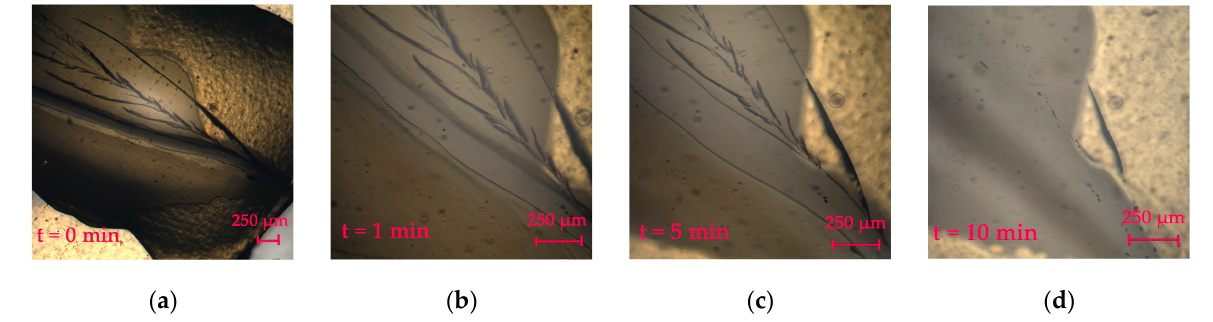
Figure 8. Optical microscopic images of healing accelerated by HCl of copolymer 1 (AAm/AAc = 84.5/14.5): ( a ) t = 0 min; ( b ) t = 1 min; ( c ) t = 5 min; ( d ) t = 10 min.